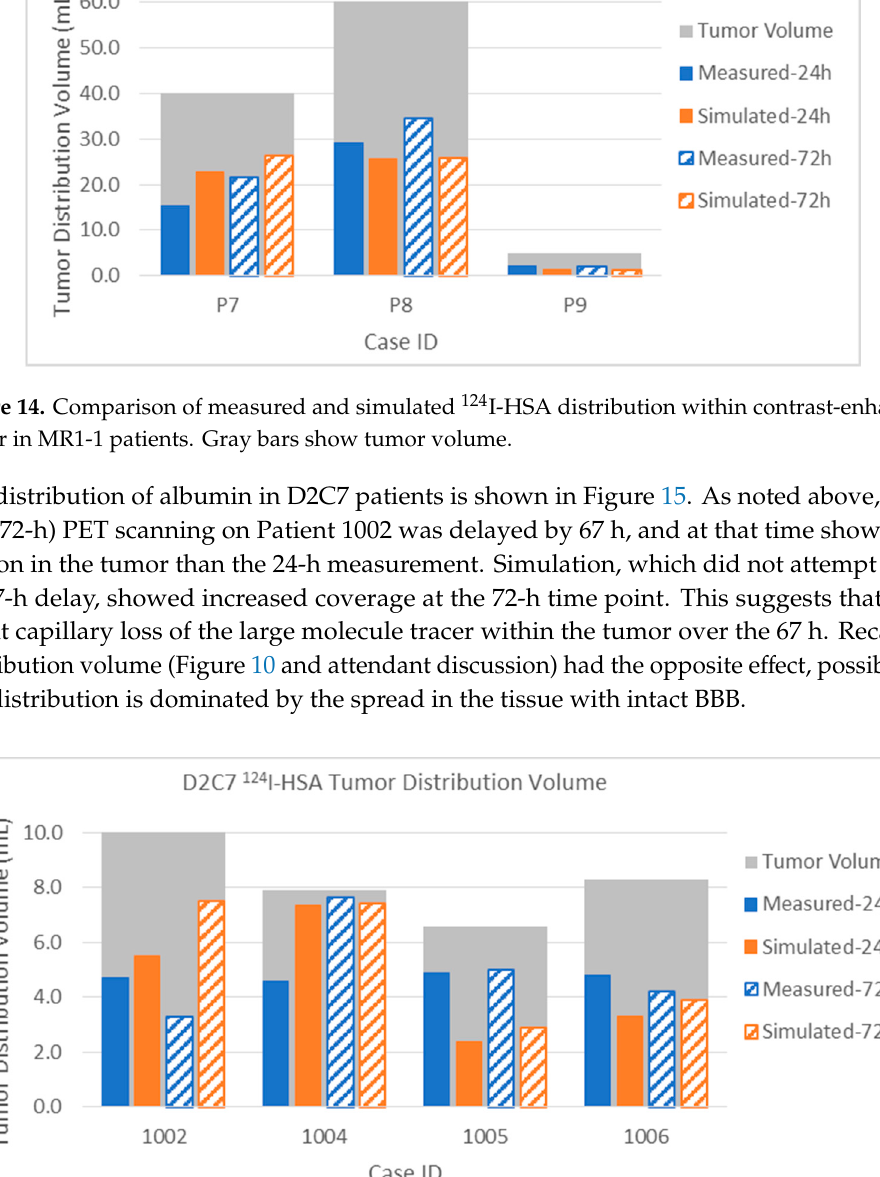
20 of 37 Figure 13. Diminishing returns. ( a ) Distribution volume vs. infusion volume of Gd-DTPA in D2C7 patients who had one catheter. ( b ) V d vs. V i of 124 I-HSA in MR1-1 patients and D2C7 patients with quantitative PET imaging. Figure 13b plots the 124 I-HSA distributions of all of the MR1-1 and D2C7 patients for which there is quantitative PET data in this study. Four showed a sharp decrease in slope, and three maintained a relatively steady rate. Note that even for this large HSA molecule, and even for the first 24 h, the ratios Vd/Vi usually are less than 1, instead of being closer to 5 as would be expected at the canonical interstitial volume fraction of 0.2. Further details on the distribution volumes are discussed, and are fully reported in Table A1 (Appendix A). 3.2.2. Tumor Distribution Volume In this section, we examine the measured and simulated distributions within the enhancing tumor, which were identified by differencing pre- and post-contrast T1-weighted MRI from the pre-